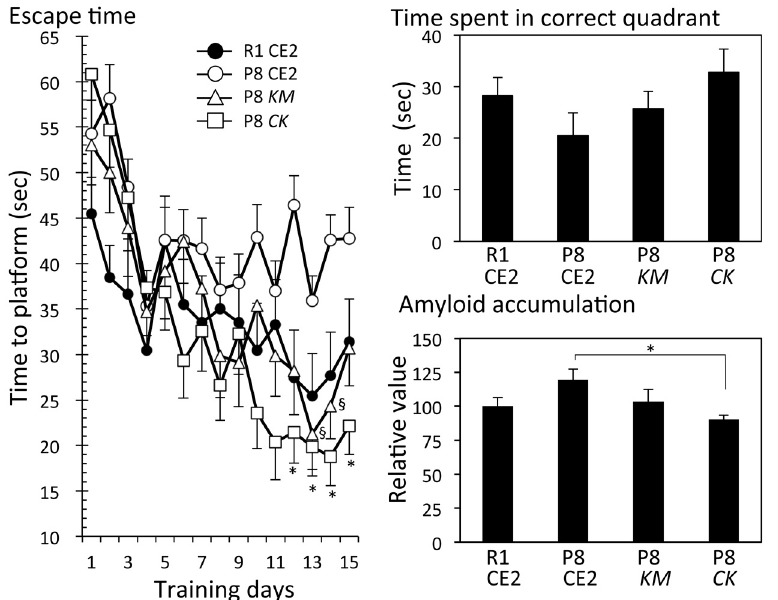
Fig 1. Evaluation of cognitive function and amyloid accumulation in 4-month-old senescence- accelerated mice. P8 mice were fed a normal diet (P8, n = 9), Kurozu Moromi containing diet ( KM , n = 9), or a concentrated Kurozu containing diet ( CK , n = 9) for 5 weeks from 12 weeks old. R1 mice were fed a normal diet (R1, n = 16). Cognitive function was evaluated using the Morris water maze test at 15 weeks of age. Left panel shows escape time during the training phase (R1 CE2, n = 16; P8 CE2, n = 9; P8 KM , n = 9; P8 CK , n = 9). § p < 0.05, P8 CE2 vs . P8 KM ; * p < 0.05, P8 CE2 vs . P8 CK . Right upper panel shows results of the probe test. Right lower panel shows amyloid accumulation (R1 CE2, n = 3; P8 CE2, n = 3; P8 KM , n = 3; P8 CK , n = 3). Results are expressed as mean ± SE. * p < 0.05, vs . P8